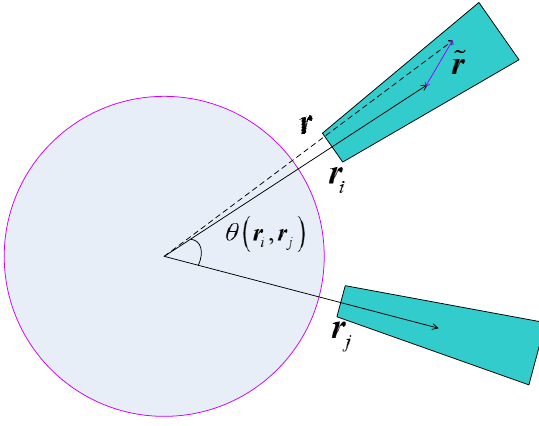
Figure 1. Mode direction and angle